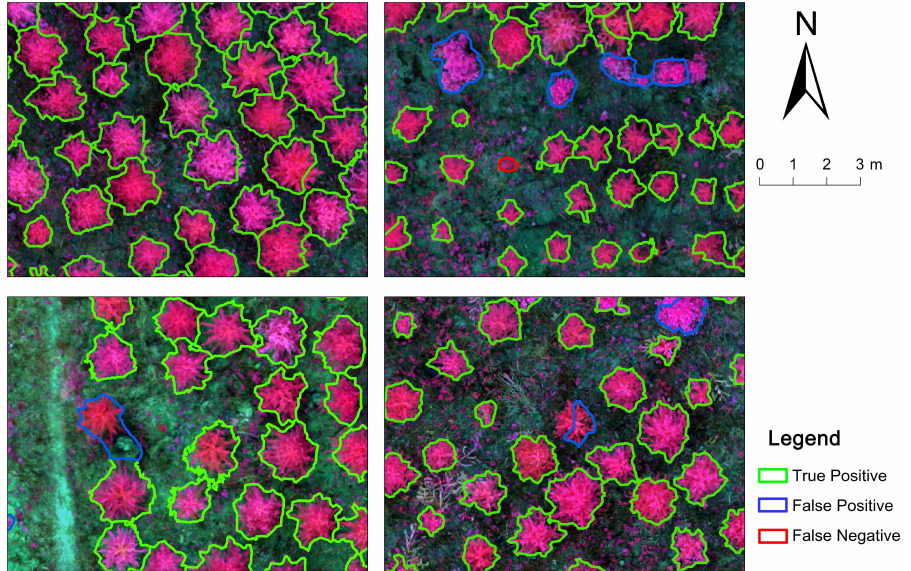
Figure 6. Examples of individual tree detection using the CHM for MCWS algorithm. Green polygons represent the correctly identified trees; Blue polygons represent the false identified trees (e.g., incomplete tree polygons, overidentified tree polygons, and broad-leaved trees); Red polygons represent omitted